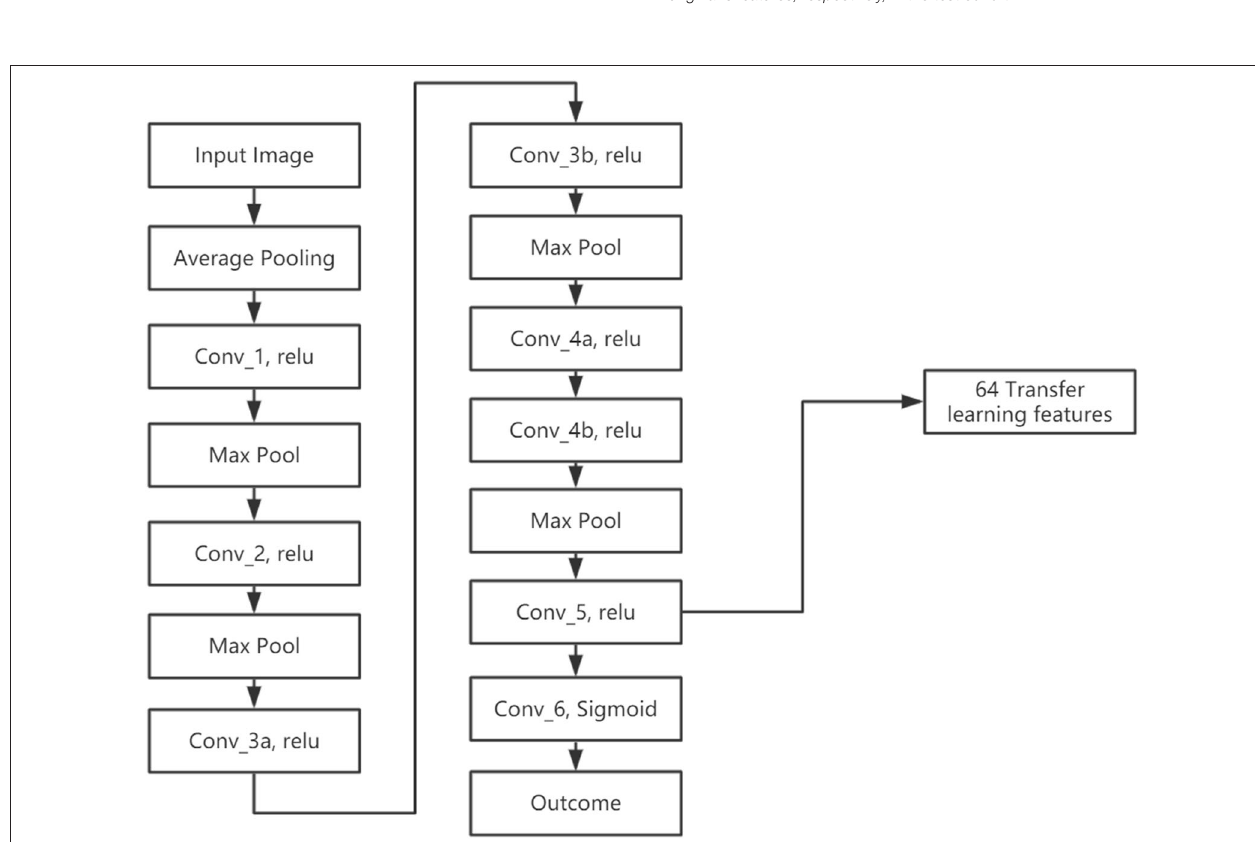
FIGURE 3 | Architecture for pretrained CNN using LUNA16